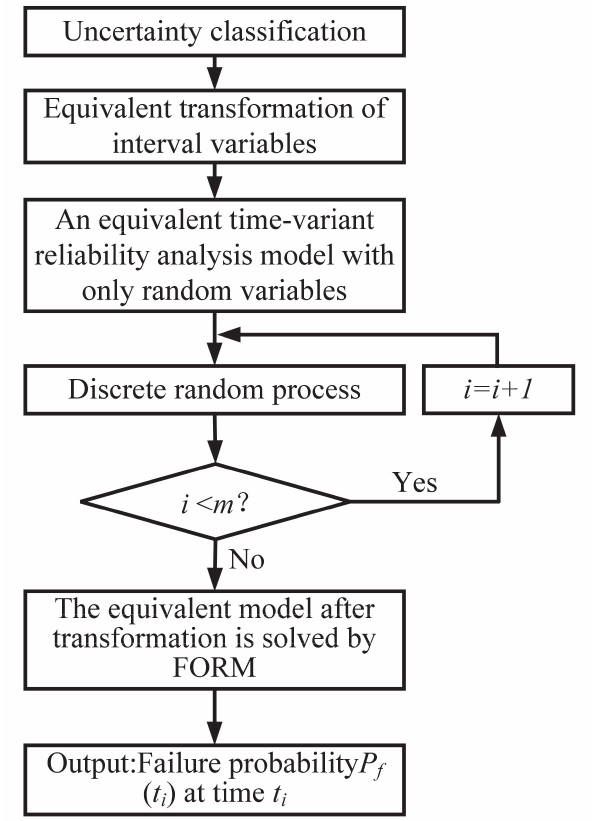
Figure 3. Algorithm flow